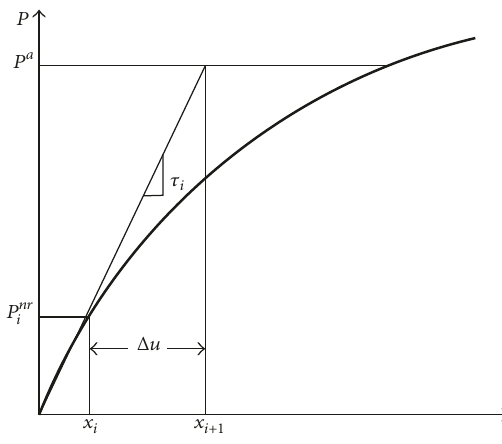
Figure 3: Newton-Raphson solution, one